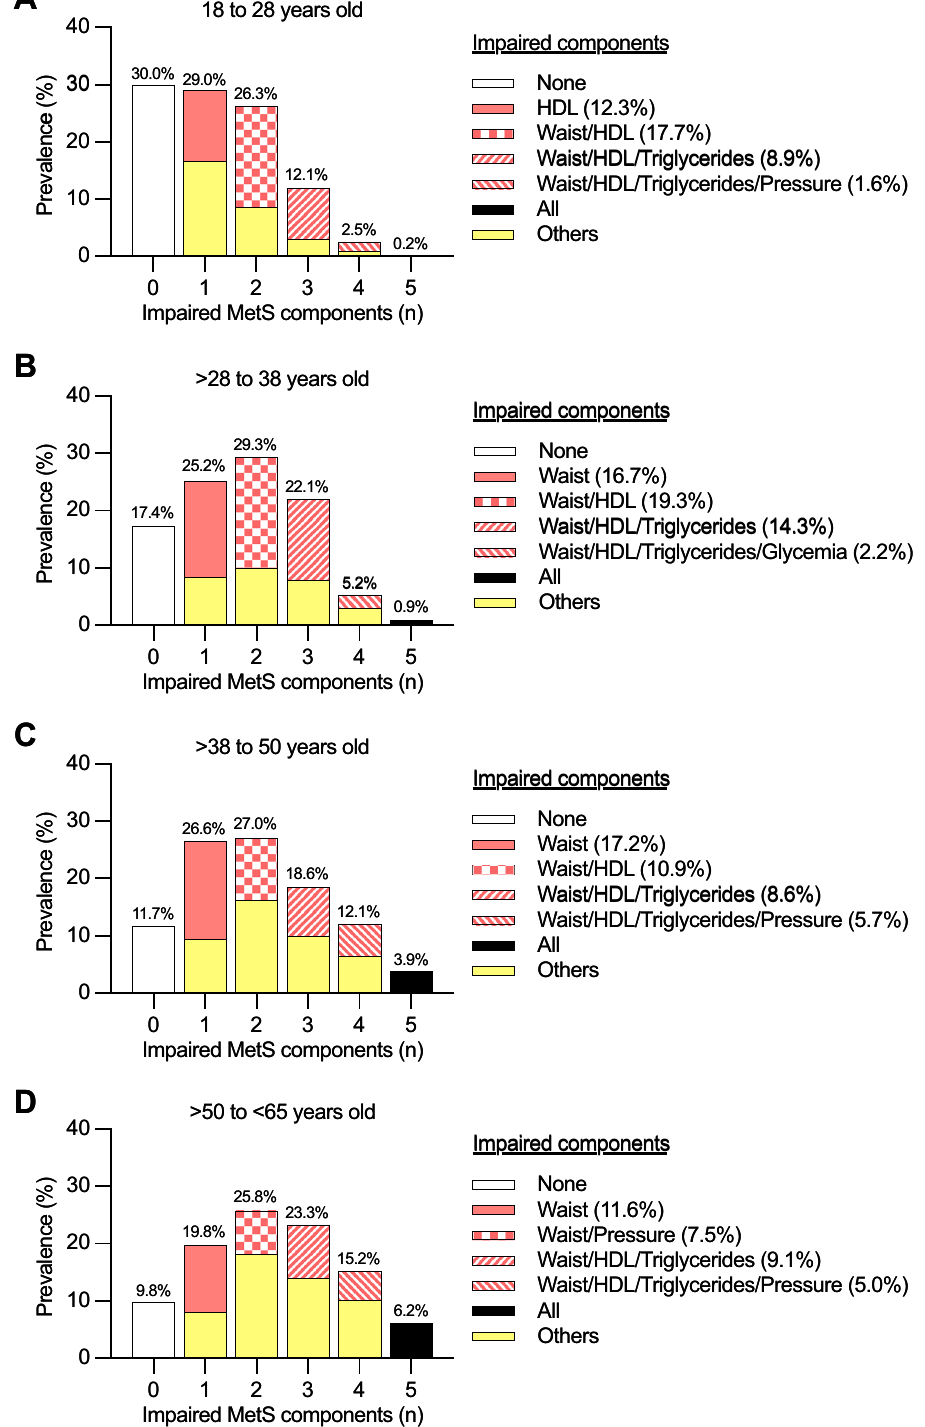
Figure 3. Prevalence of subjects with different number of metabolic syndrome (MetS) components by age. The most prevalent combination of MetS components is highlighted in subjects with one to four components. All percentages were calculated relative to the total subjects within each age group. Waist, waist circumference; HDL, high-density lipoprotein cholesterol; Pressure, blood pressure; Others, other combinations of MetS